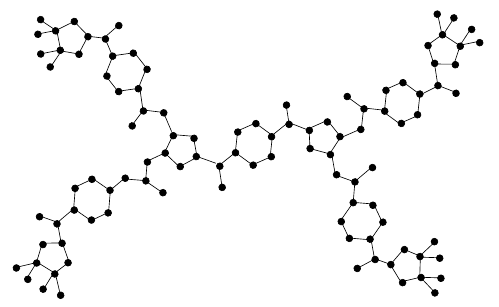
Figure 8. The graph G 2 ( 2 ) of dendrimer nanostar NSC 5 C 6